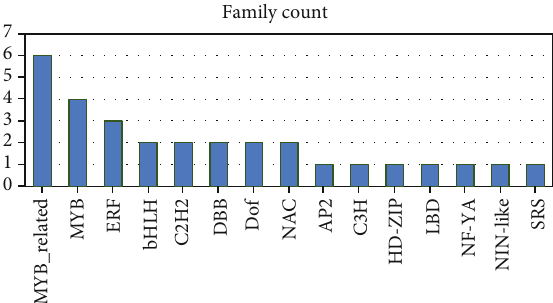
Figure 5: Distribution of the TFs that were upregulated in C. tetragonoloba in response to drought